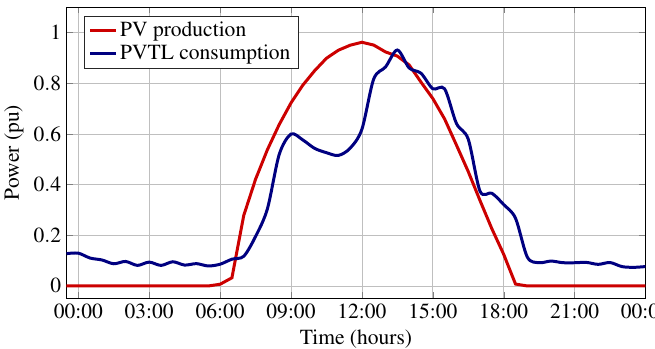
Figure 14. Production and consumption curves over a period of a